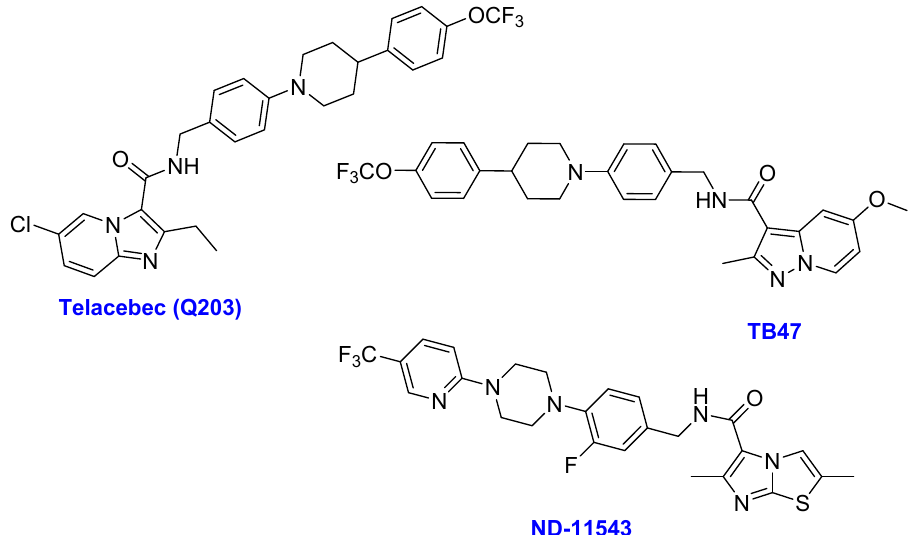
Figure 6. The structures of Q203 and its analogs (TB47 and ND-11543) that show potential as novel TB agents.